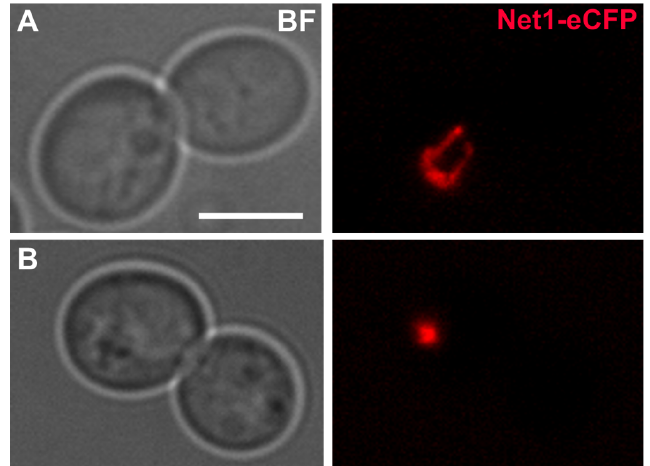
Figure 2. The effect of stress in the nucleolus of yeast cells blocked at G2/M. ( A ) Typical dumbbell morphology of a nocodazole (Nz) G2/M arrest at 25 ◦ C with the rDNA metaphase loop; the strain carries the Net1 protein with an eCFP tag (pseudo coloured red). Bar, 5 µ m. ( B ) A cell culture coming from a Nz arrest was stressed by shifting the temperature from 25 ◦ C to 37 ◦ C for 90 min, while keeping the Nz arrest. A dramatic compaction of the rDNA signal is observed upon HS. Strain background: W303. This is original